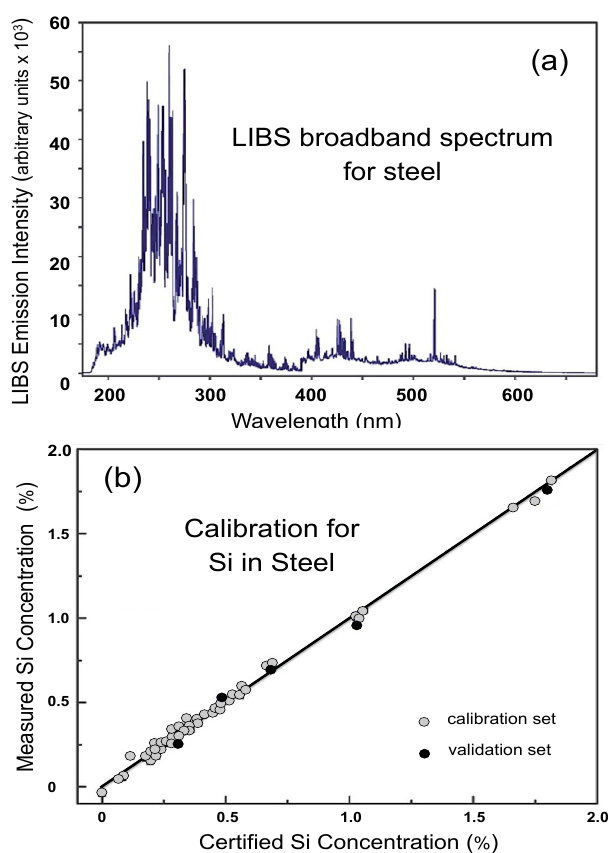
Figure 9. LIBS emission spectrum for a steel sample between 200–550 nm ( a ) and calibration / validation data for Si in di ff erent steels ( b ) using a dominant factor based PLS with spectrum standardization (modified from Reference